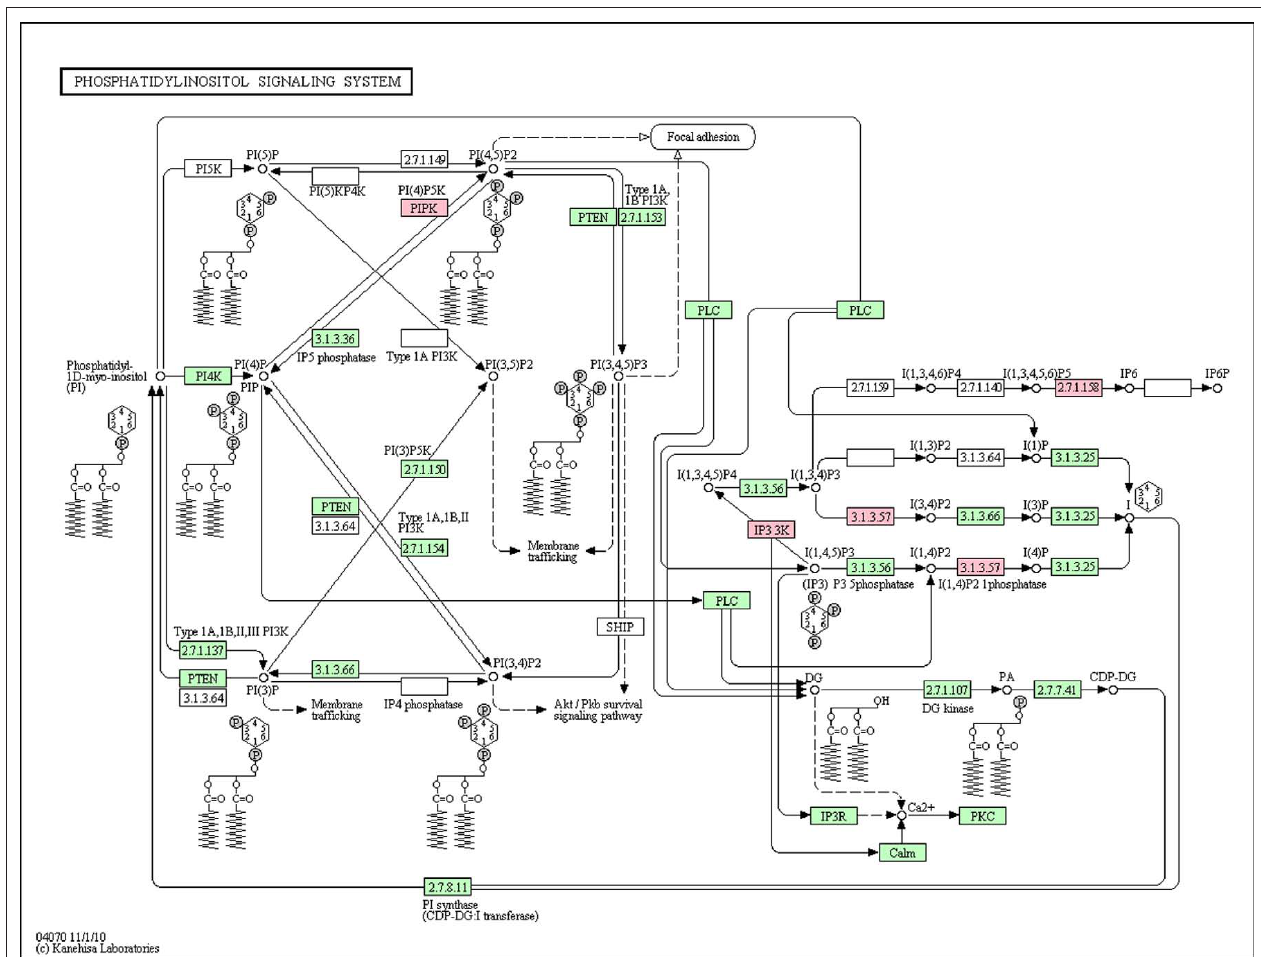
product from transcript CG30295-RB), Ipp (Inositol polyphosphate 1-phosphatase), and PIP5K59B (CG3682 gene product from transcript CG3682-RA). Green boxes represent other members in the pathway database for Drosophila melanogaster